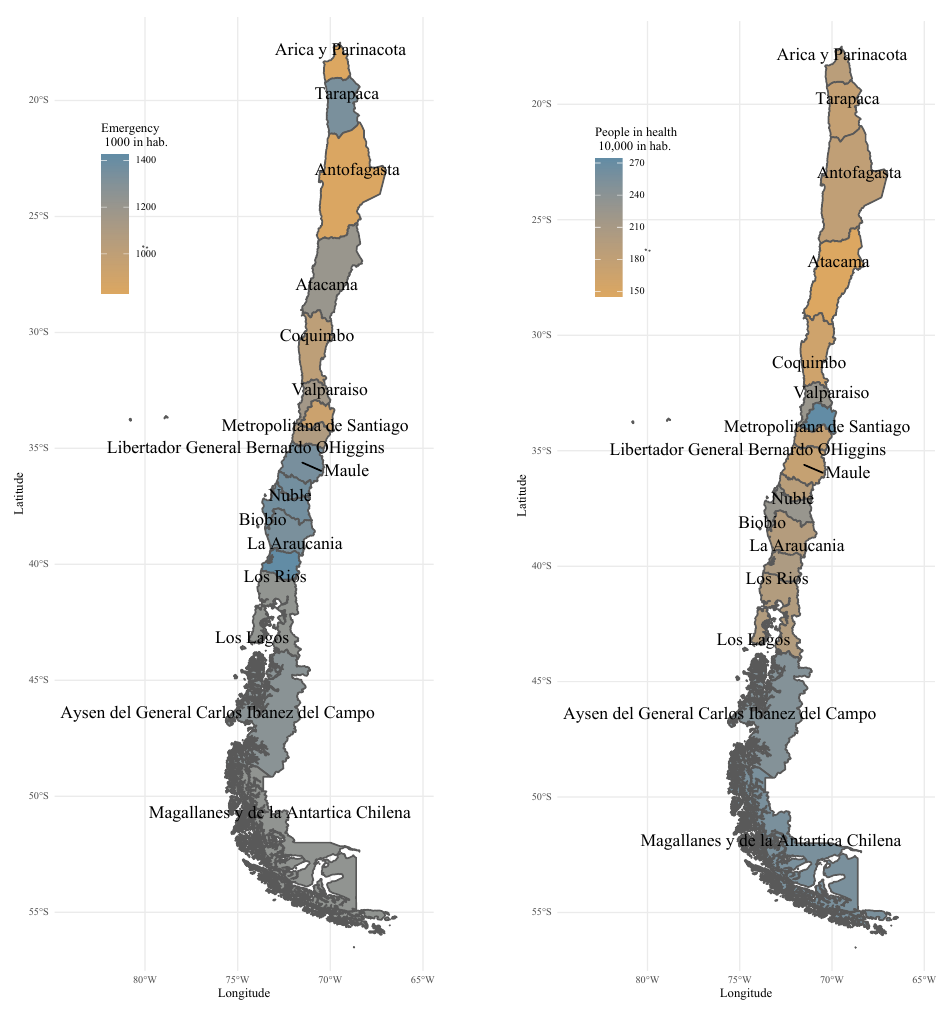
Figure 1. Emergencies and people in health care